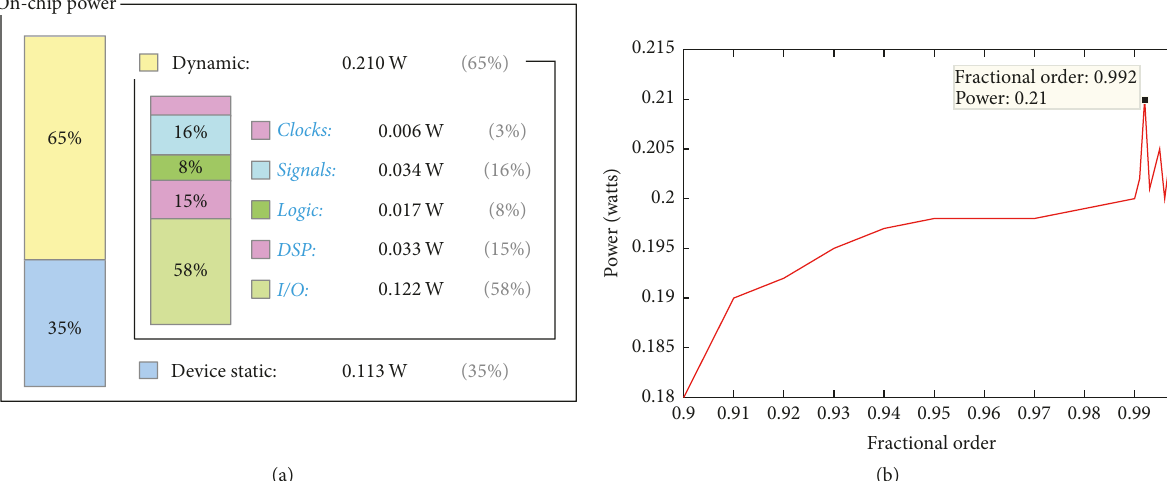
Figure 18: (a) Power utilized and (b) power utilization versus fractional order of GAFOPID